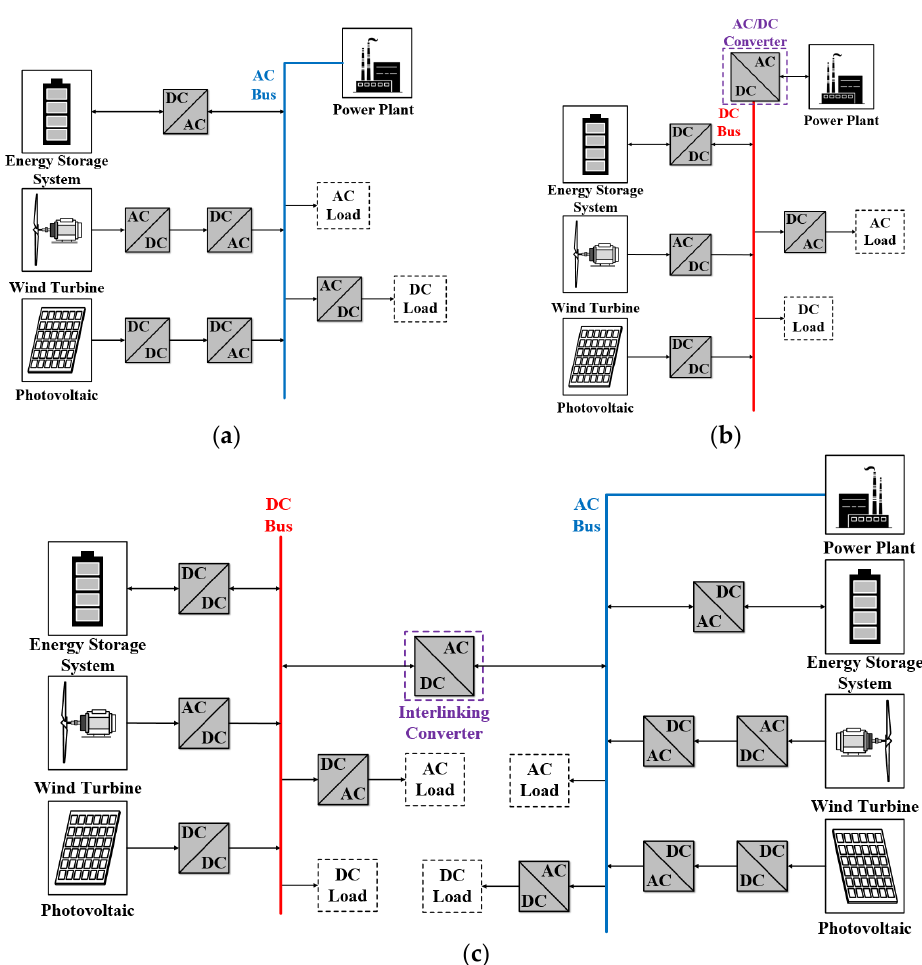
Figure 1. Classification of microgrids with voltage type ( a ) AC; ( b ) DC; ( c ) hybrid AC/DC.